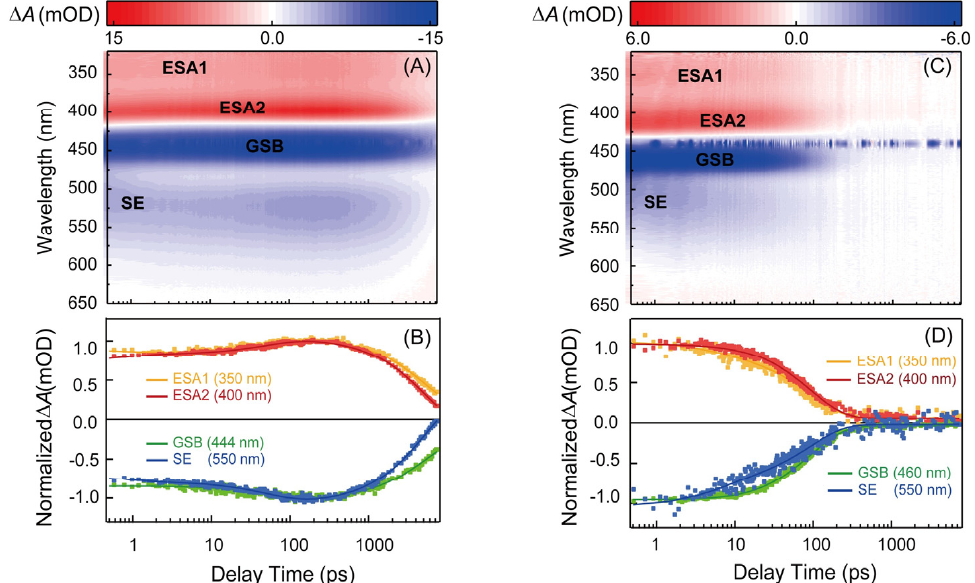
Figure 3. ( A ) Femtosecond time-resolved transient-absorption spectra and ( B ) representative kinetic traces extracted from global fitting of transient-absorption data of proflavine (50 µ M) in buffer solution (pH = 7.4); ( C ) femtosecond time-resolved transient-absorption spectra and ( D ) representative kinetic traces extracted from global fitting of transient-absorption data of the intercalation complex of PF − DNA (50 µ M) in buffer solution (pH = 7.4).